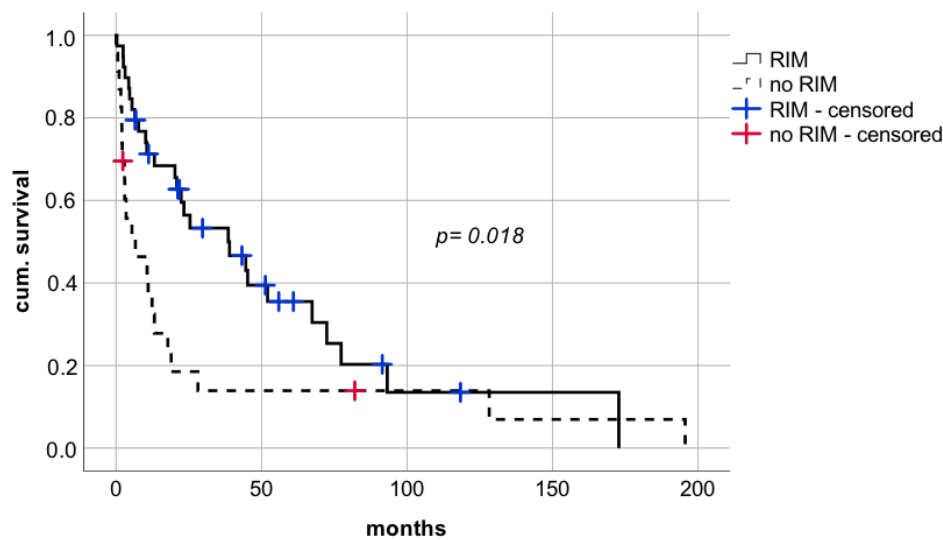
Figure 4. Comparison of patients with or without restrictive immunosuppressive management after diagnosis of de novo lung carcinoma after liver transplantation. RIM—restrictive immunosuppres- sive management.